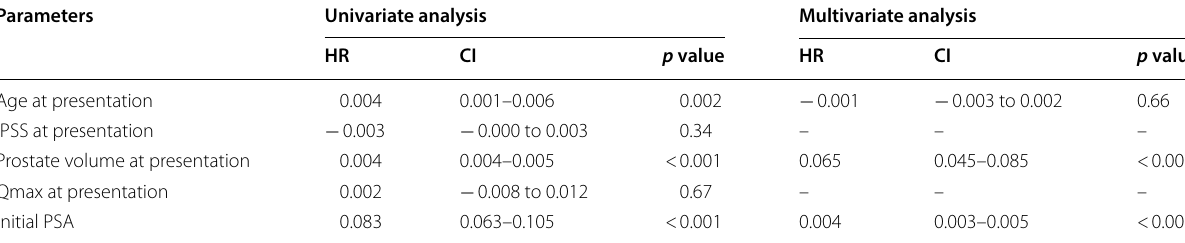
Table 3 Univariate and multivariate regression analysis to detect independent predictors of